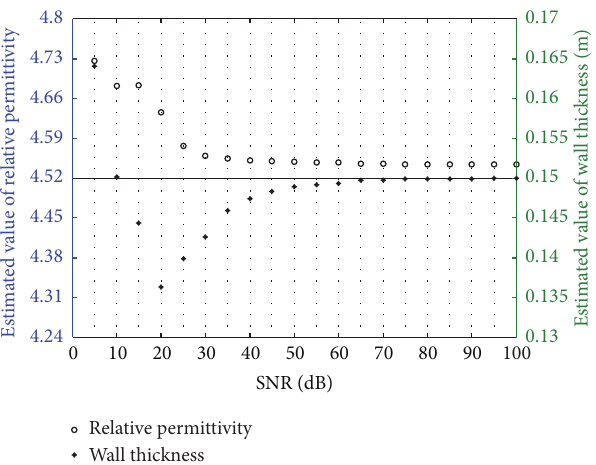
Figure 5: Entropy versus